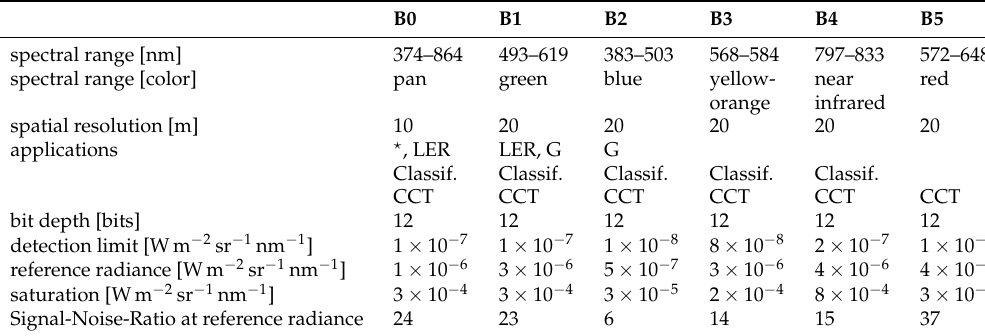
Table 5. Recommended performance parameters for nocturnal multispectral satellite imagery for urban areas. (cid:63) normalization and single-lamp